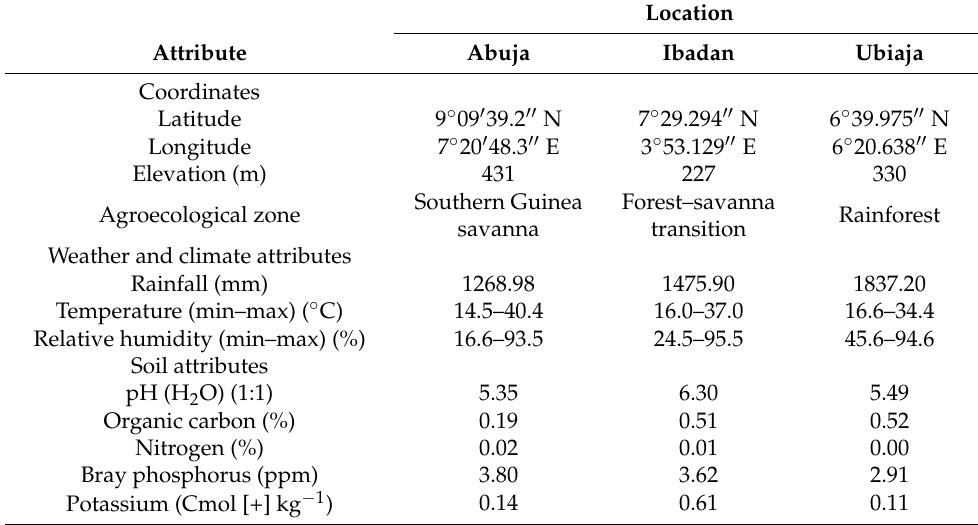
Table 1. Environmental conditions of the three different experimental sites in Nigeria during